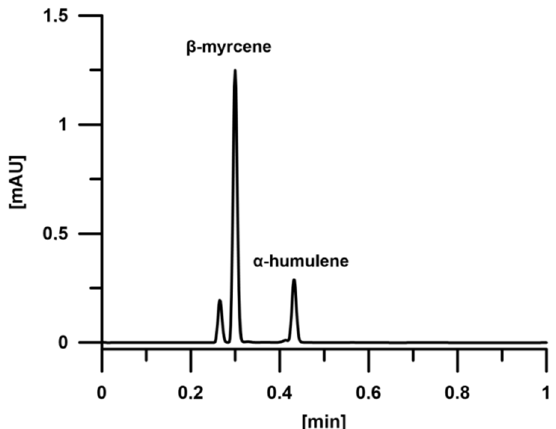
Figure 2. The chromatogram of β-myrcene and α-humulene by UPC 2 (ultra-performance convergence chromatography) on HSS C18 SB (100 mm  3.0 mm; 1.8 μm) column; 35 °C, ABPR (automated back pressure regulator): 12.6 MPa; pure CO 2 ; isocratic